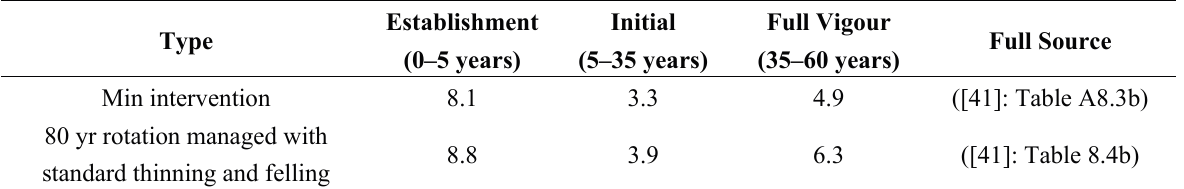
(i) minimum intervention; and (ii) 80 year rotation with standard thinning and felling due